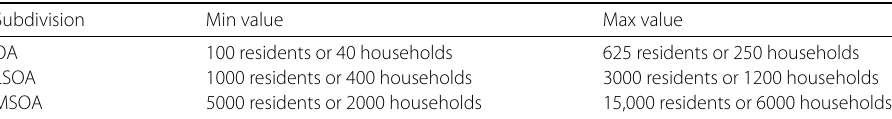
Table 2 Minimum and maximum values for each subdvision type in the UK